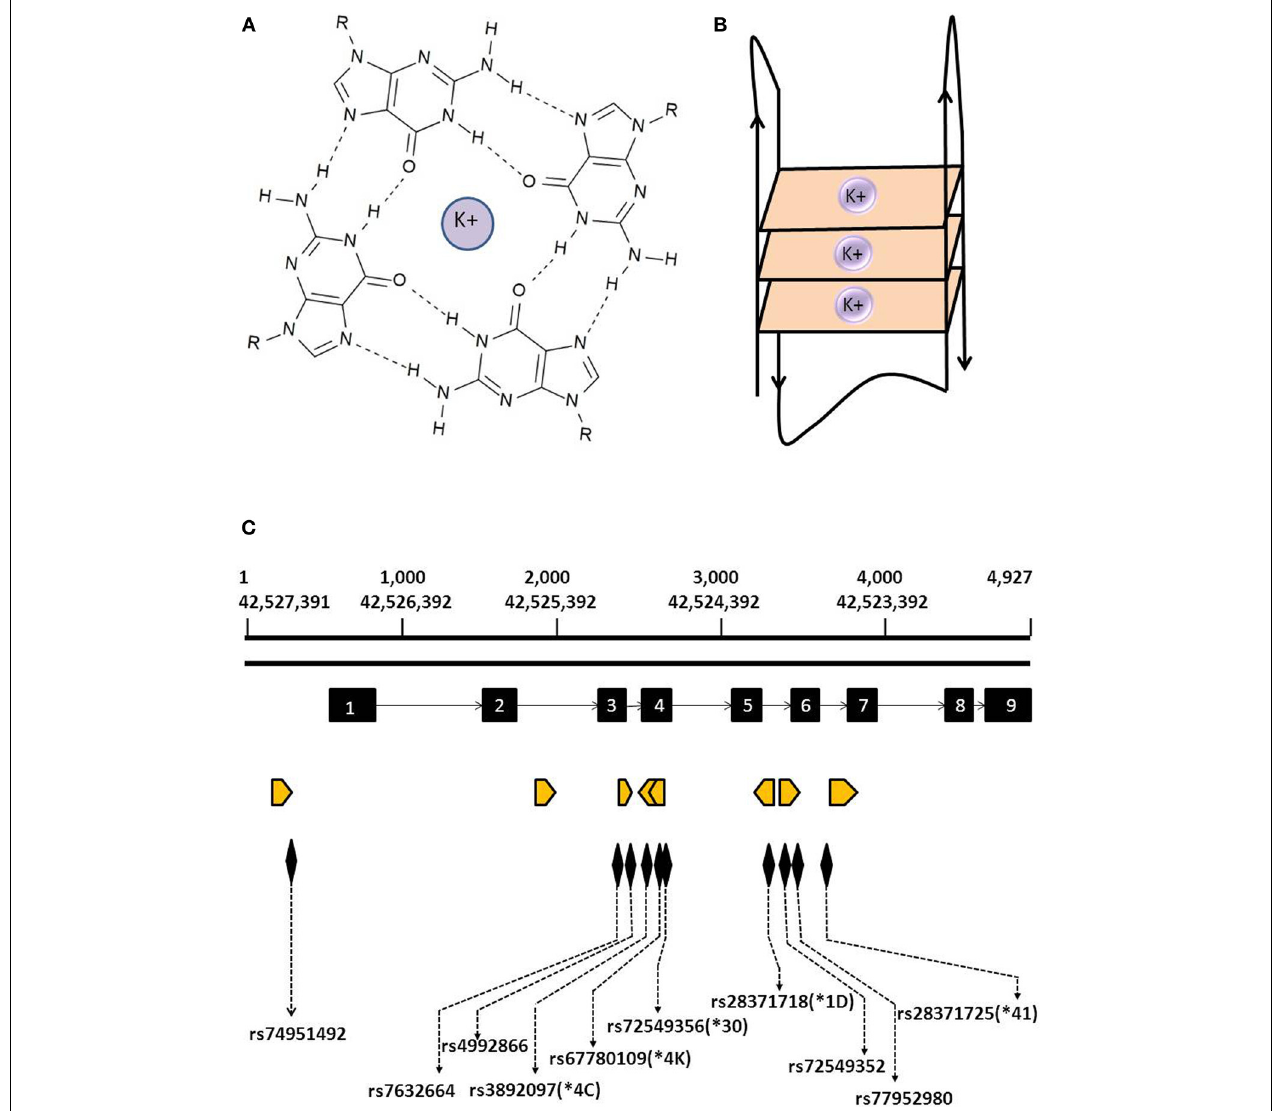
FIGURE 1 | Structure of G4 and location of predicted G4s within the CYP2D6 gene. (A) Guanine tetrad formed by the association of four guanine basesviaHoogstenhydrogenbondsinacoplanararrangementandstabilizedby apotassiumion. (B) SchematicrepresentationofaG-quadruplexformedbythe